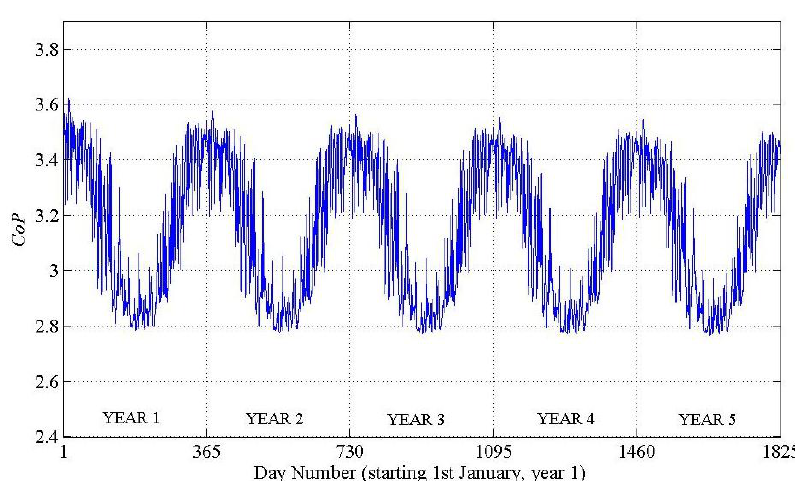
Figure 8. Mean daily heat pump CoP (detached